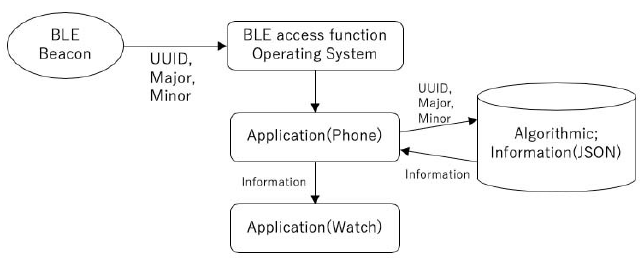
Figure 3. Delivering sightseeing information by BLE beacon.